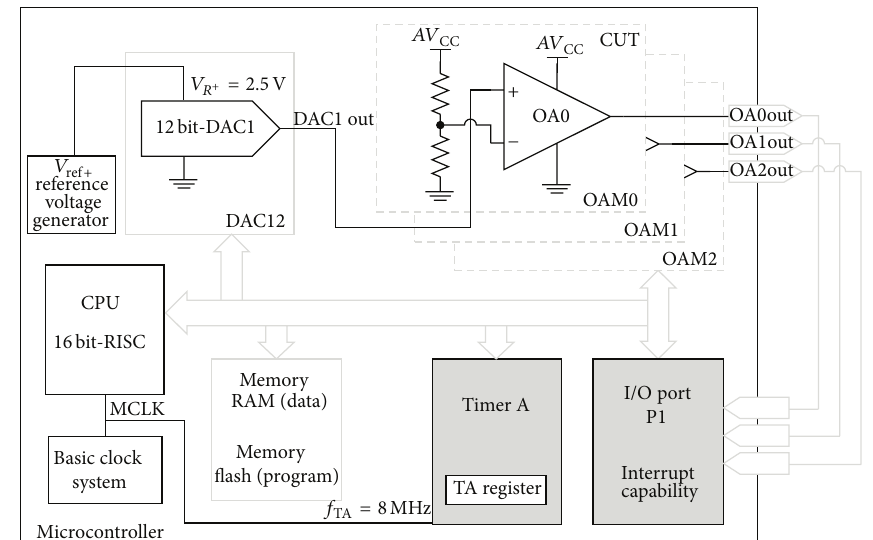
Figure 11: Arrangement for testing slew rate.